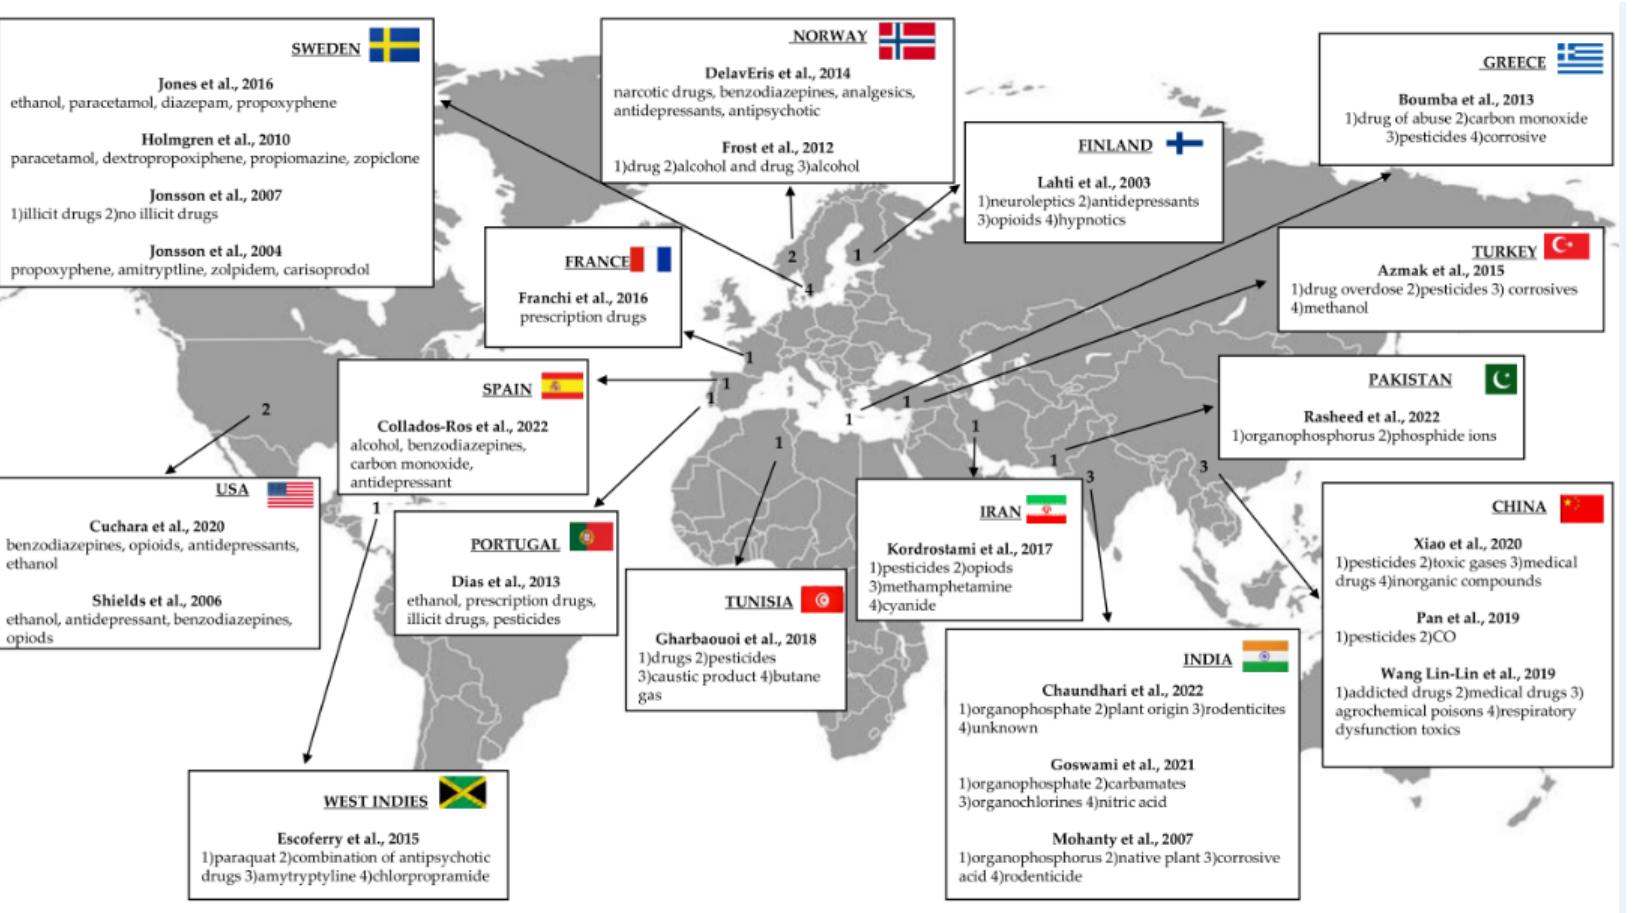
Figure 2. Representative figure illustrating the number of autopsies in cases of suicide by self-poisoning and the most frequent types of toxic substances used and their worldwide distribution, according to the articles included in this review